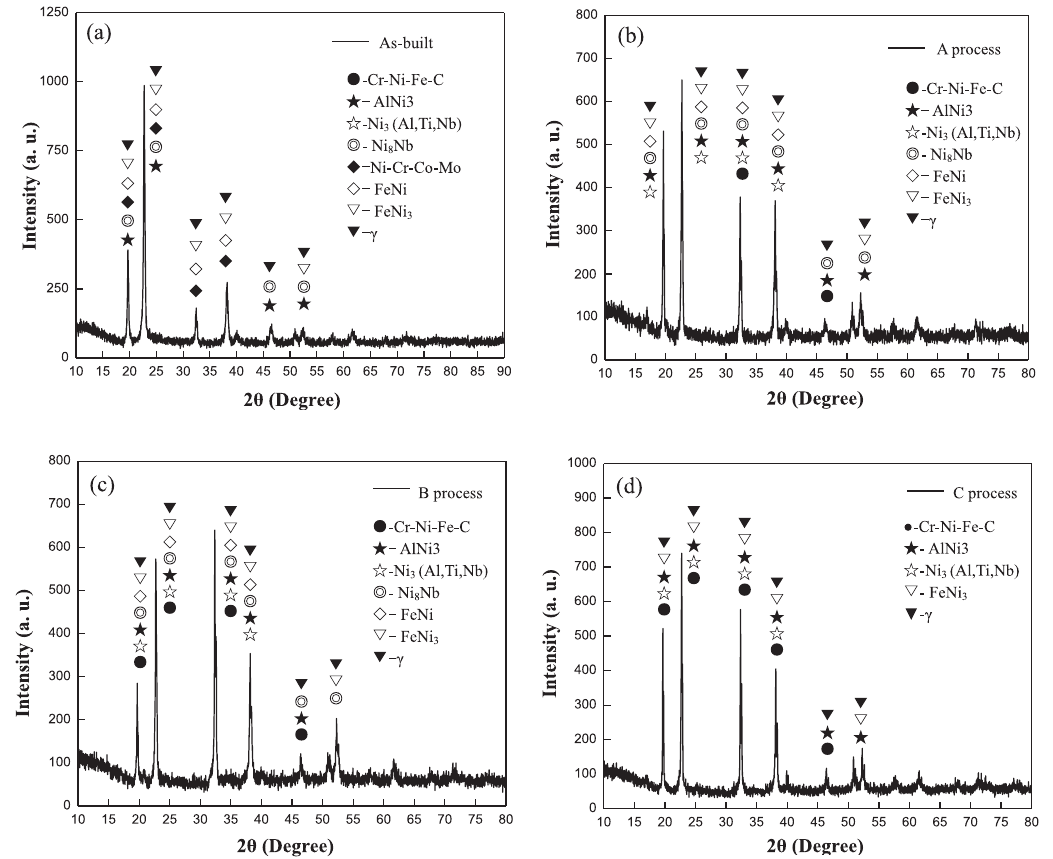
Figure 4: XRD curve of Inconel-718 Ni-based alloys under different conditions: (a) As-built alloy, (b) A process, (c) B process and (d) C